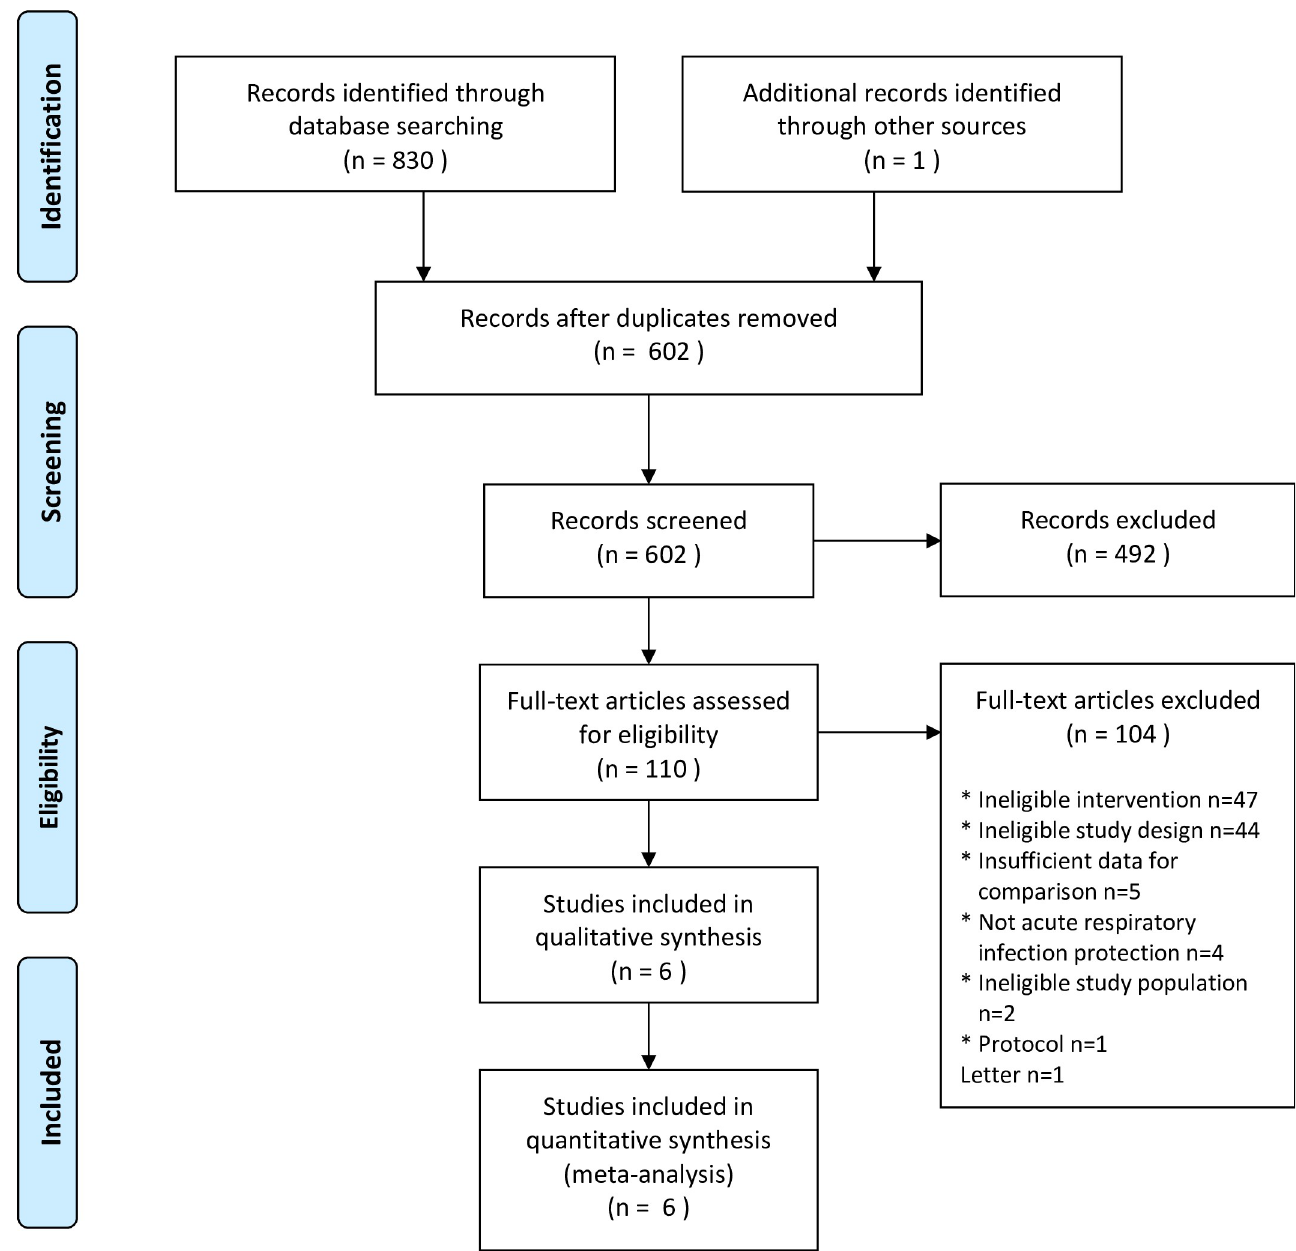
Fig 1. Flow diagram showing stages of database searching and study selection as per PRISMA guidelines. https://doi.org/10.1371/journal.pone.0242901.g001 viruses compared with MSM (5.7% vs. 7.9%; RR = 1.12; 95% CI: 0.88–1.41; p = 0.36), despite non-significant heterogeneity among the studies (I 2 = 26%) (Fig 3). Laboratory-confirmed bacterial colonization Two trials reported laboratory-confirmed bacterial colonization [6, 7], with lower risk of labo- ratory-confirmed bacterial colonization while using N95 compared with MSM (5.6% vs. 13.7%; RR = 2.04; 95% CI: 1.58–2.64; p < 0.001) (S3 Fig).